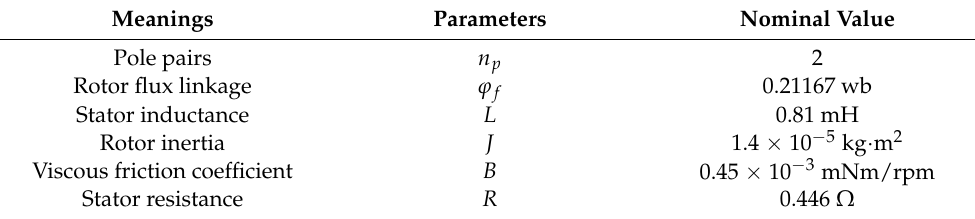
Table 1. Parameters of PMSM system in simulations when the ambient temperature is 25 ◦